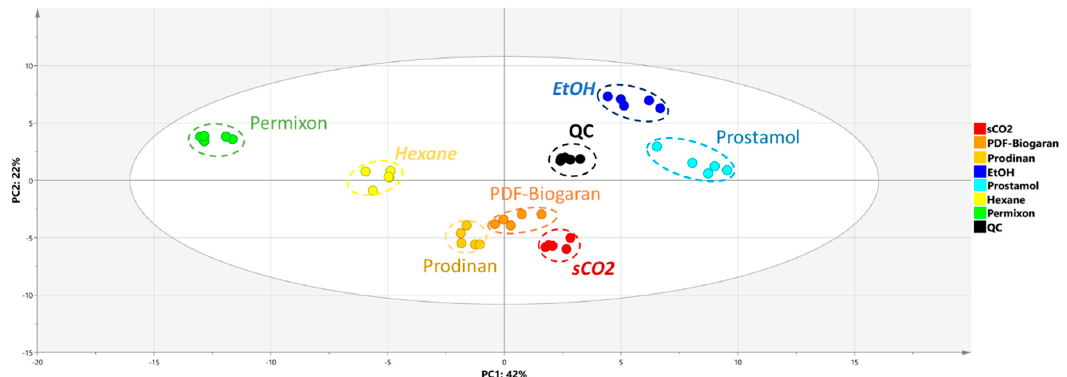
Figure 3. PCA score plot of LC-MS dataset (dotted circles highlight each class for visualization purpose). Laboratory samples: sCO 2 , supercritical carbon dioxide; EtOH: ethanolic; Hexane: hexanic (two superimposed dots observed). Commercial samples: PDF-Biogaran ® and Prodinan ® (sCO 2 ), Prostamol ® (EtOH), Permixon ® (Hexane). QC: quality control samples.